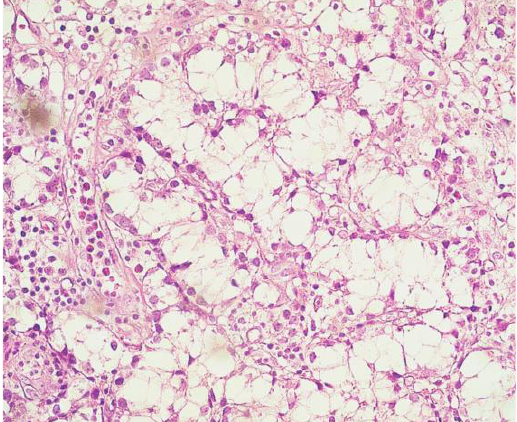
Figure 2. Proliferation of round-oval cells with clear cytoplasm, moderate cytonuclear pleomorphism with centrally located nucleoli or granular chromatin (H and E, ×40).